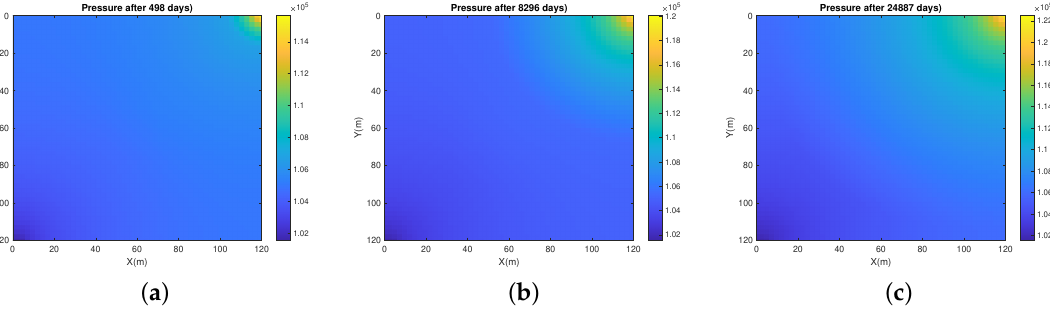
Figure 10. Pressure at different time for Example 3: ( a ) Pressure (after 498 days). ( b ) Pressure ( after 8296 days). ( c ) Pressure (after 24,887 days).